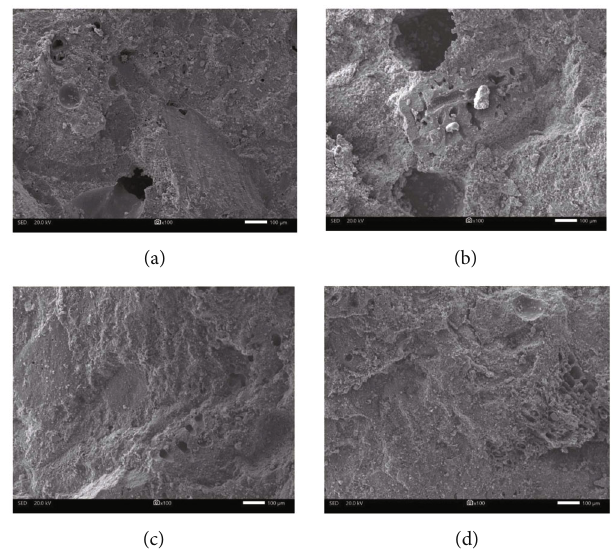
Figure 7: Pore characteristics of samples with di ff erent GO contents under 30 dry-wet cycles of sulfate erosion. (a, b) The dosage of GO is 0.00%. (c, d) The dosage of GO is 0.03%.